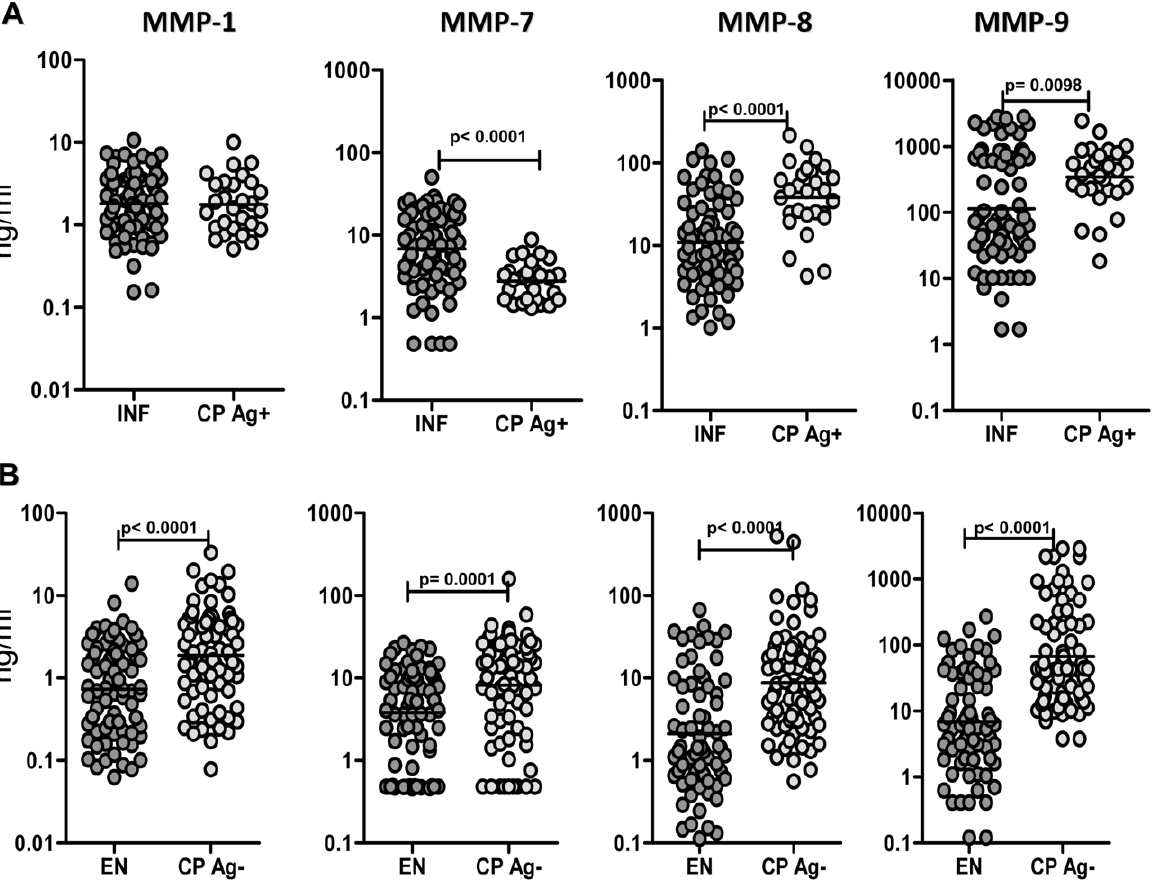
Figure 1. Filarial lymphedema is associated with elevated levels of MMPs. (A) Plasma levels of MMP-1, -7, -8, and -9 from filarial lymphedema individuals with active infection [CP Ag + ] ( n =28) and asymptomatic infected [INF] (n=74) individuals were measured by ELISA. (B) Plasma levels of MMP-1, -7, -8 and -9 from filarial lymphedema individuals without active infection [CP Ag 2 ] (n=77) and endemic normal [EN] ( n =73) individuals were measured by ELISA. P values were calculated using the Mann-Whitney